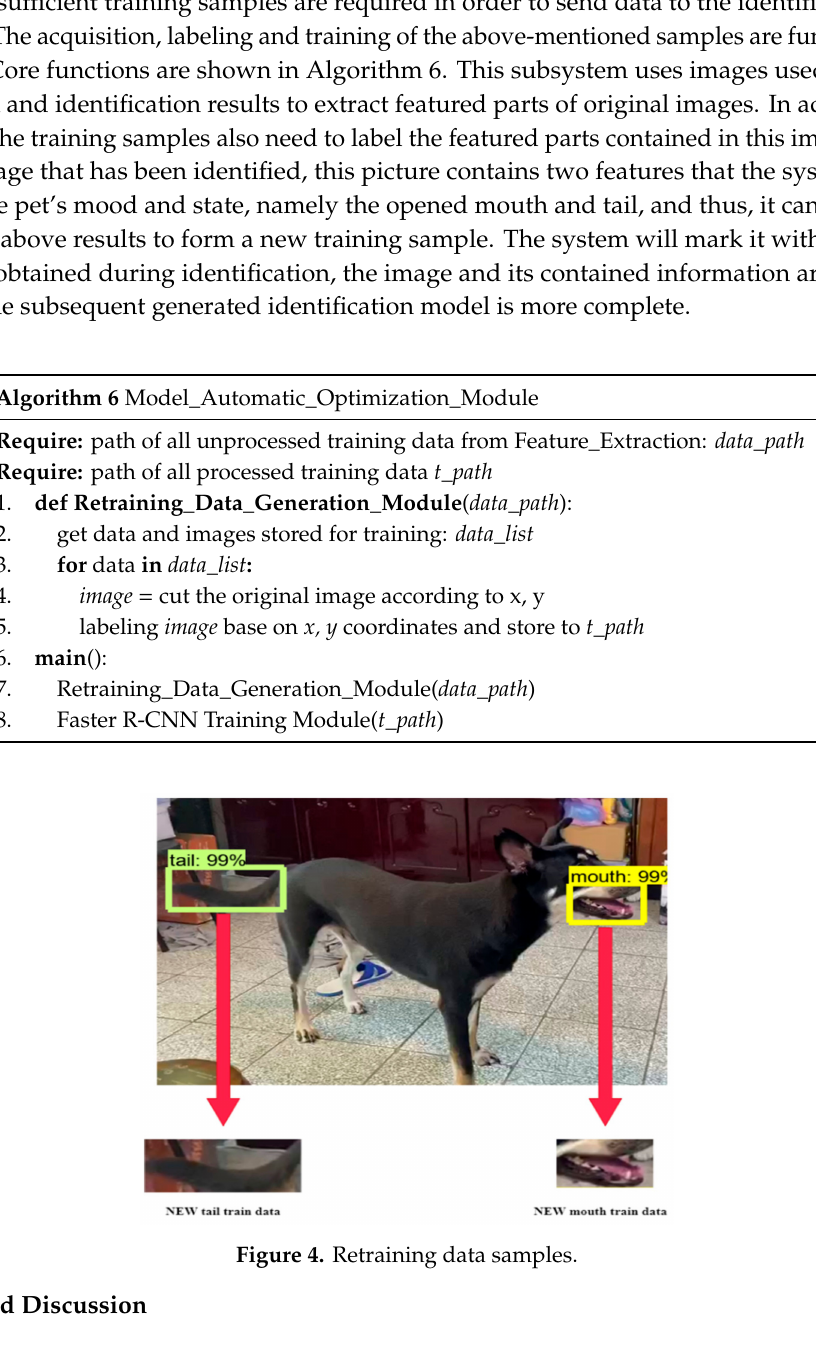
Figure 5. The proposed system used training samples to retrain the model for capturing specific featured parts. The training samples included the Stanford Dogs Dataset [21], which contains at